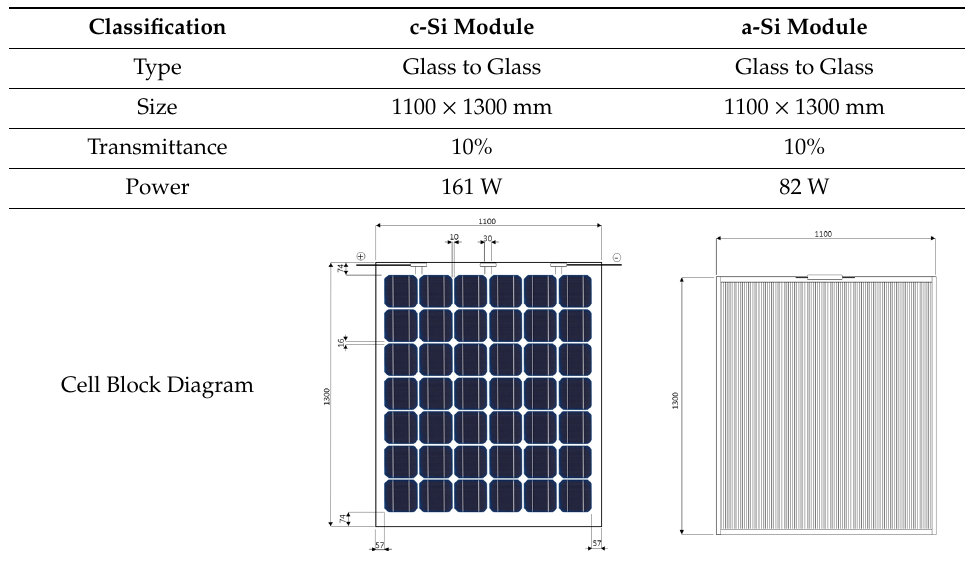
Table 2. At the reference photometric value of 1000 W / m 2 , the c-Si modules generated a voltage (Voc) of 26.21 V, a current (Isc) of 8.05 A, and a maximum power (Pm) of 160.21 W, whereas the a-Si